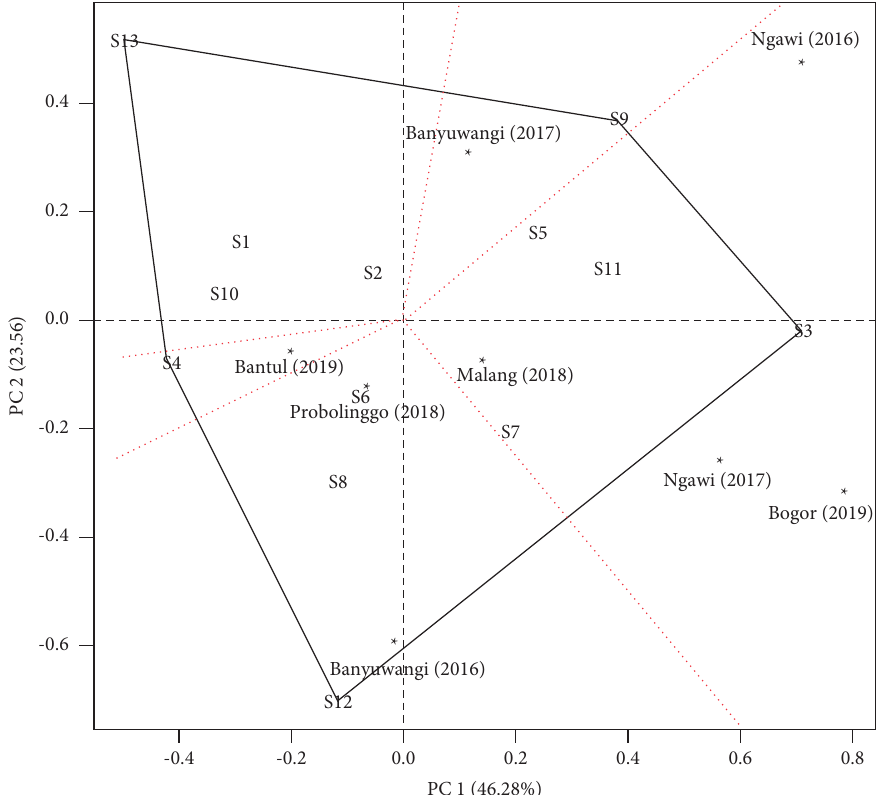
Figure 7: Mega-environments on 13 soybean lines in Indonesia during